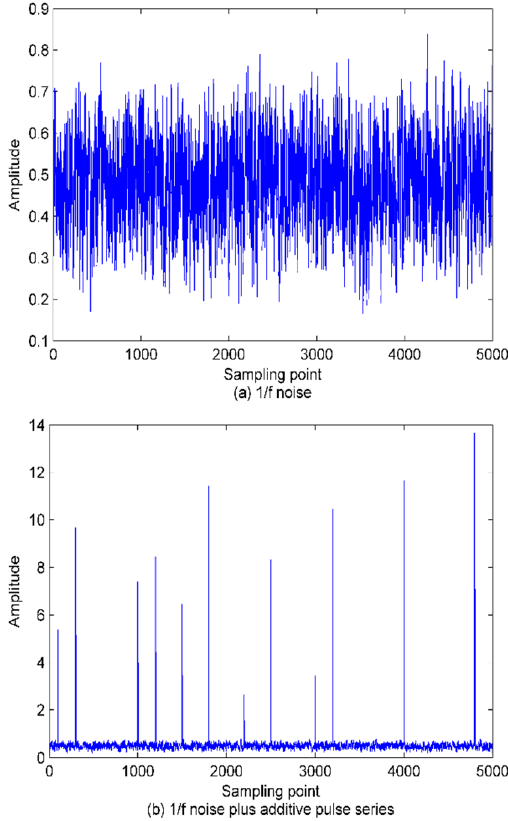
Figure 7. The time domain waveforms for; ( a ) 1/f noise ( b ) the signal plus additive pulse series.